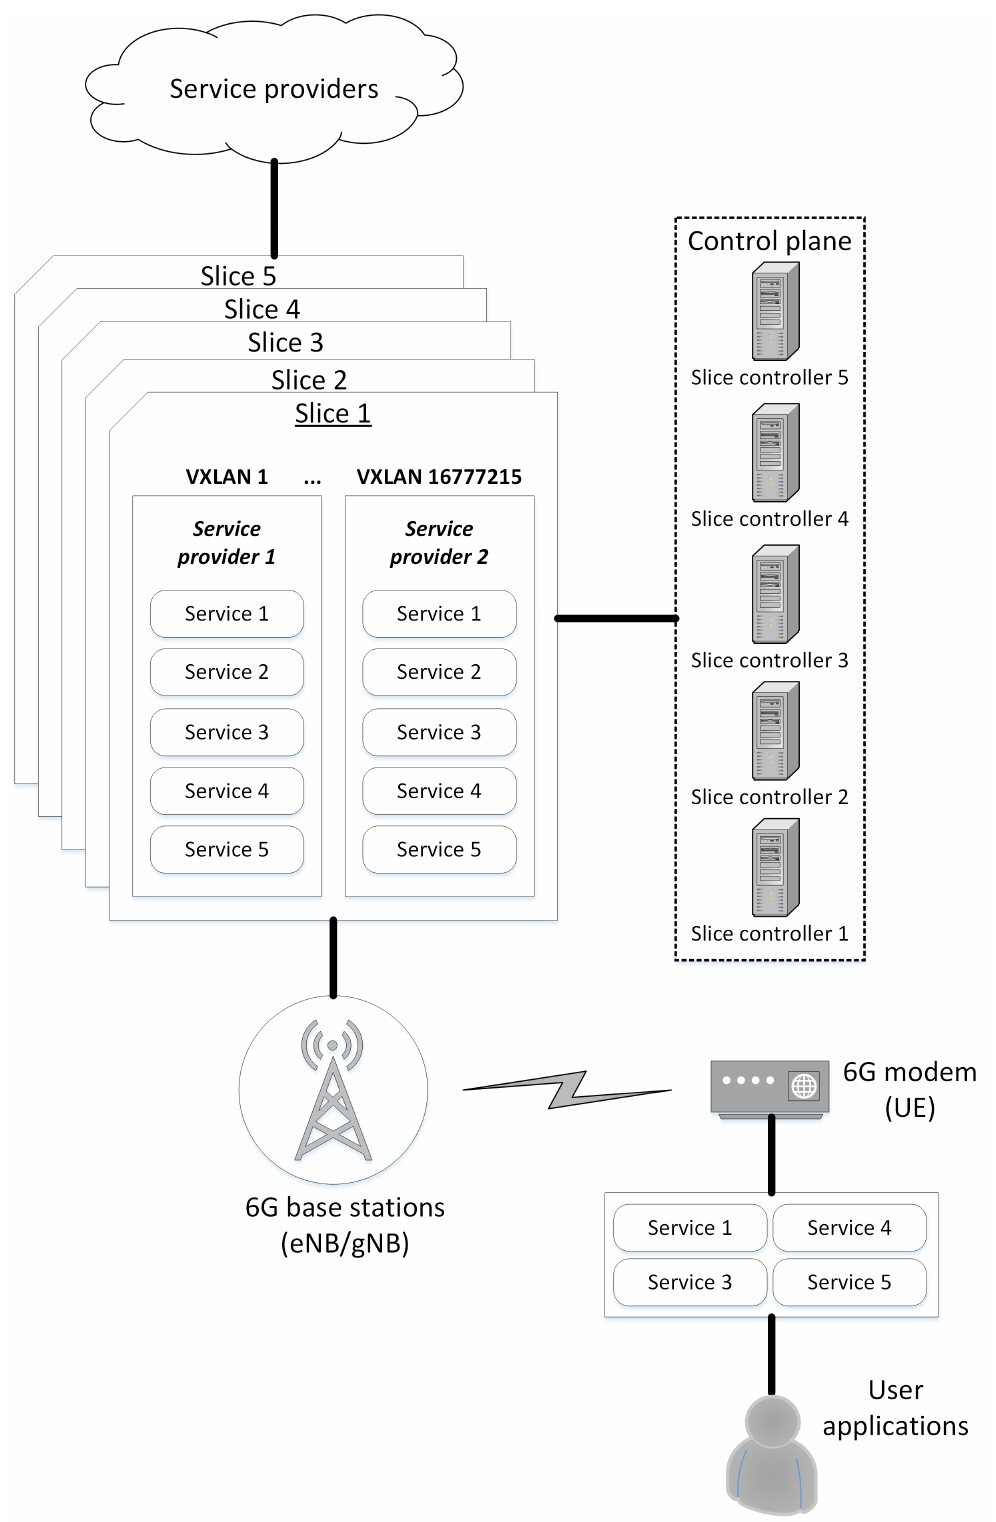
Figure 2. Service bonding and provider isolation in a multi-slice